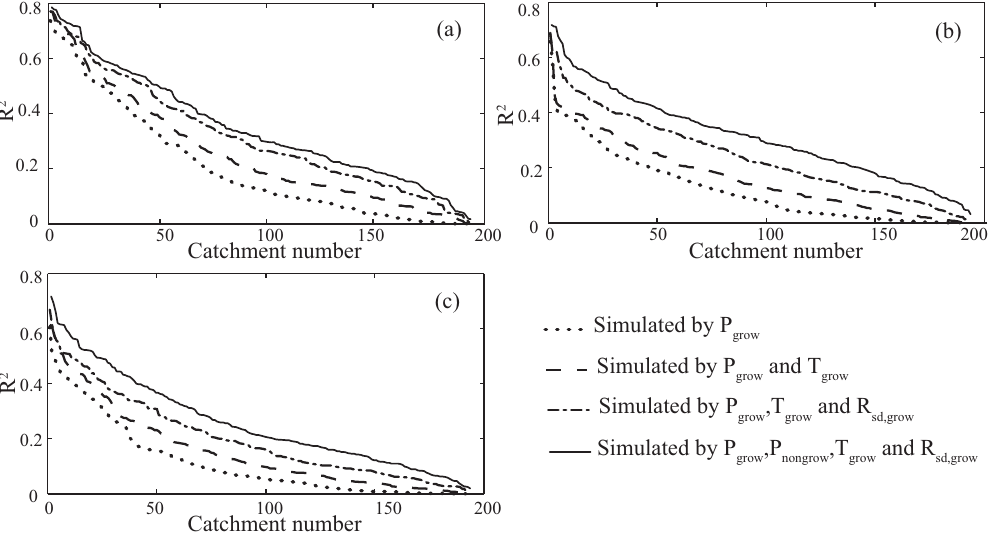
Fig. 4. Statistical distributions of coefficient of determination ( R 2 ) in elasticity estimation for (a) total fPAR ( F t ), (b) persistent fPAR ( F p ) and (c) recurrent fPAR ( F r ). Note that P grow represents precipitation during growing season, P nongrow represents precipitation during non-growing season, T represents mean temperature during growing season and R sd represents mean incoming shortwave radiation during growing